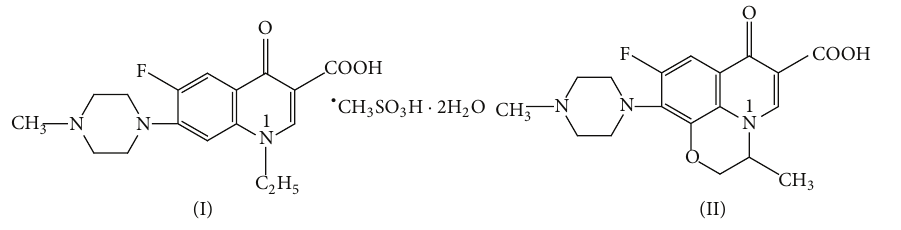
Figure 1: Structural formulae of the PFLX (I) and OFLX (II).